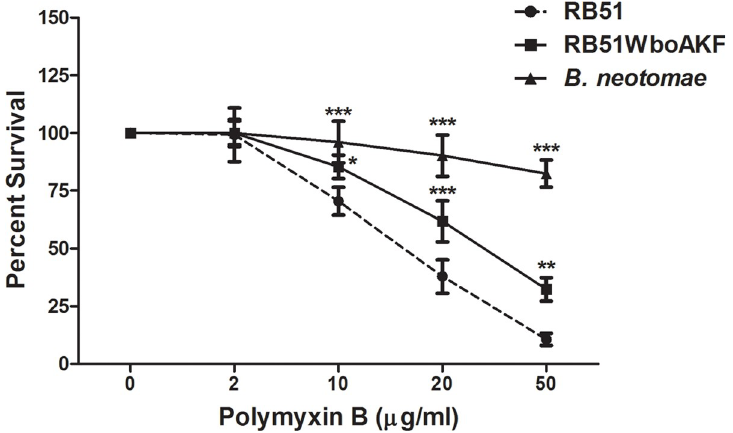
Fig 5. Bactericidal effect of Polymyxin B on strains RB51, RB51WboAKF and B . neotomae . Average results from three assays are expressed as percentage of the bacteria surviving in the absence of Polymyxin B. Asterisks indicate statistically significant differences from the RB51 strain. � , P < 0.05; �� , P < 0.01; ��� , P < 0.001.